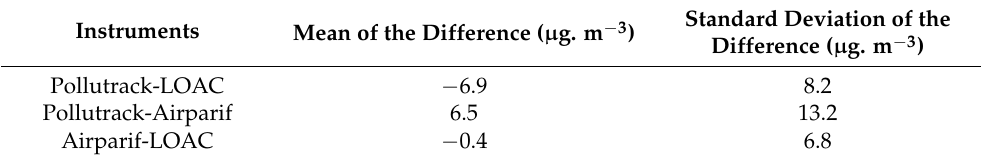
Table 2. Statistics of the differences between the 3 sets of measurements for the PM10. Instruments Instruments